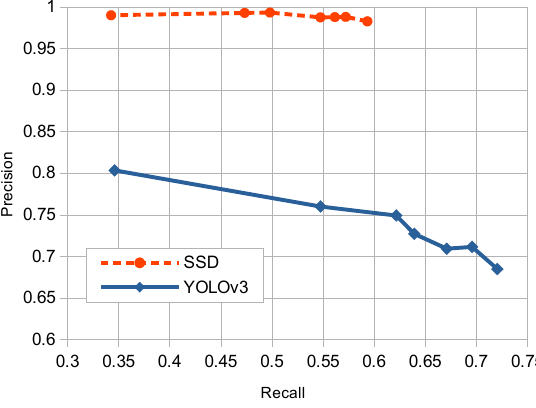
Figure 9. Respective precision-recall curves for SSD and YOLOv3 detectors.